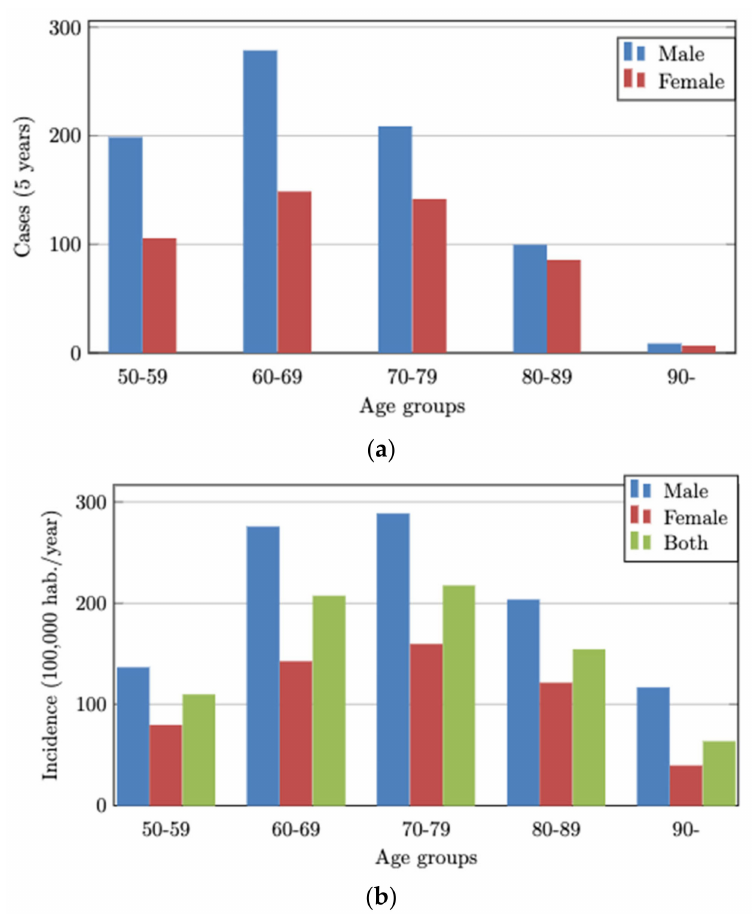
Figure 2. ( a ) Total CRC cases by age groups and sex for 5 years. ( b ) Mean observed CRC incidence by age groups and sex during one year. The sociodemographic information and aspirin exposure in patients with CRC (Table